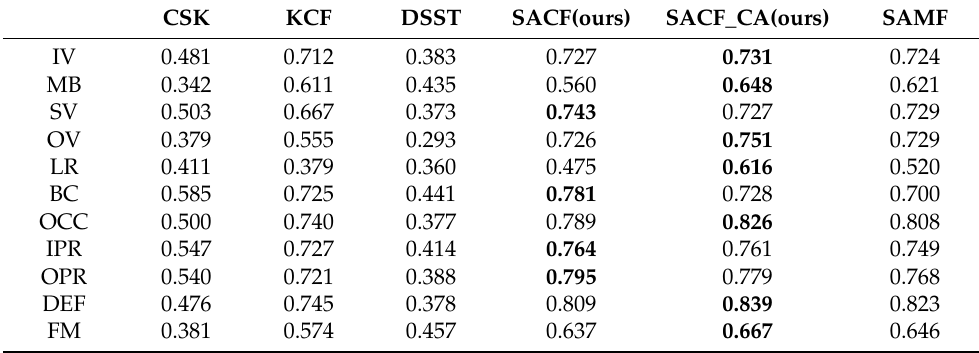
Table 2. DP values of the six algorithms for different scene